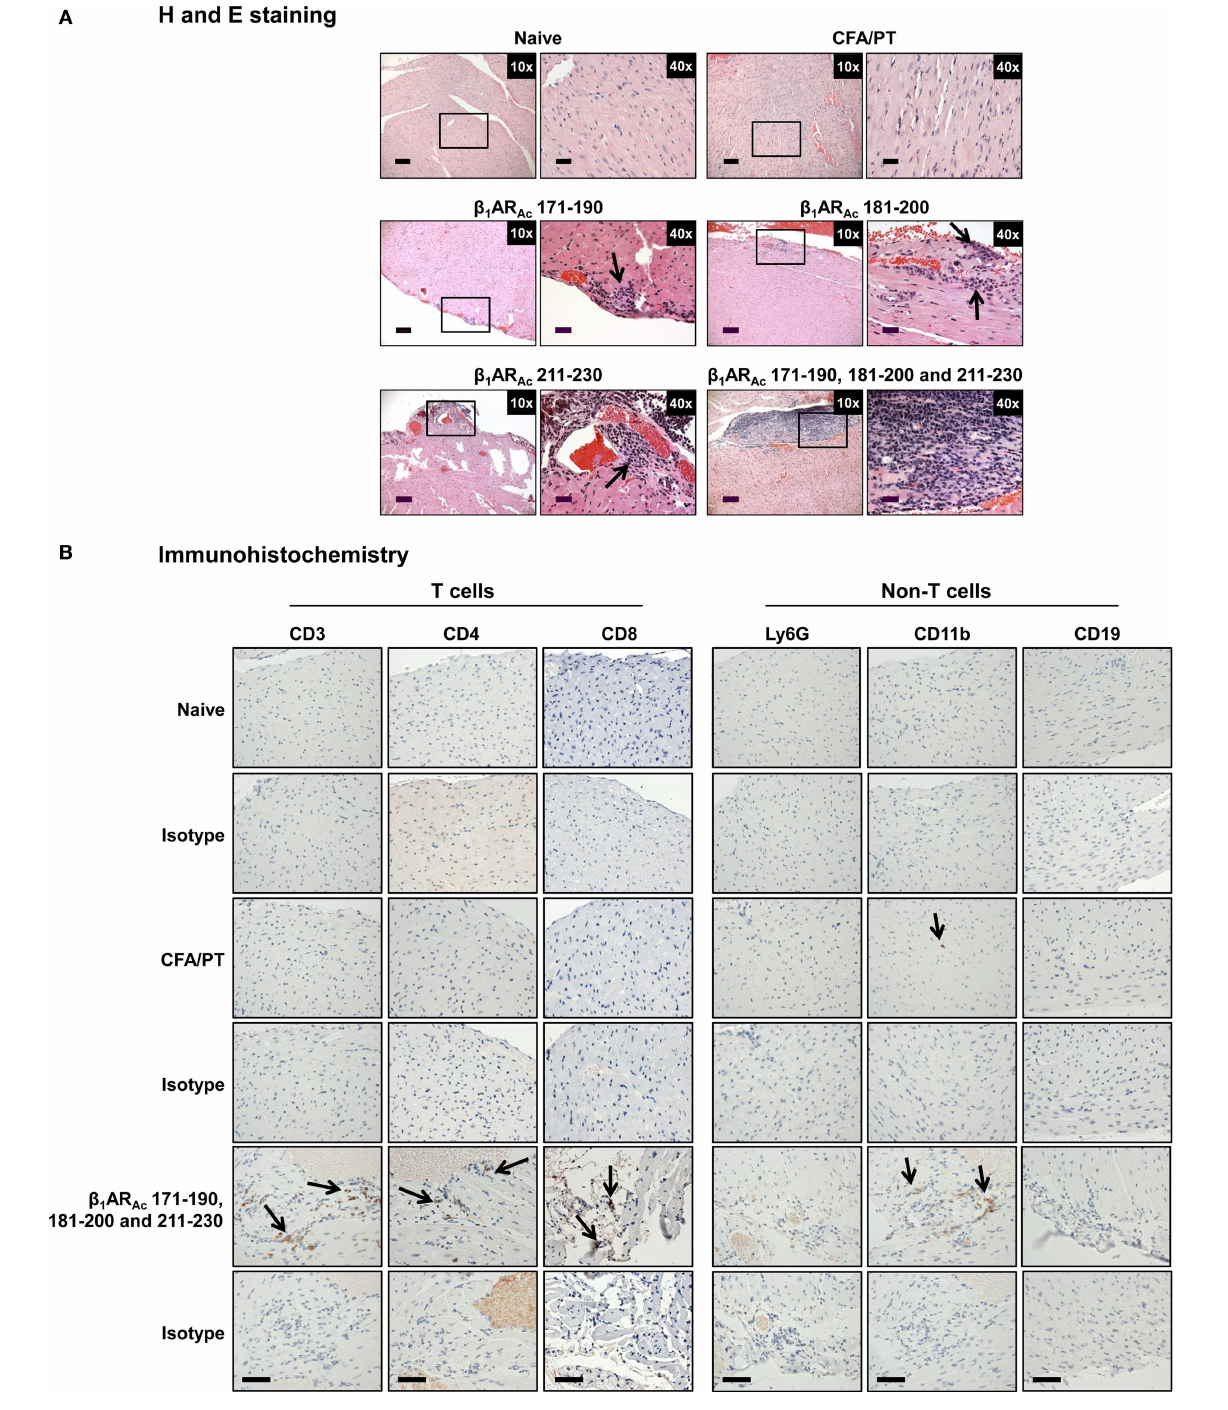
FigUre 2 | Histological evaluation of hearts from animals immunized with β 1 AR Ac peptides. (a) Hematoxylin and eosin (H&E) staining. Groups of mice were immunized with or without indicated peptides in complete Freund’s adjuvant (CFA) twice with an interval of 7 days. At termination on day 21, hearts were collected to determine inflammatory changes by H&E staining analysis. Mild myocarditis as indicated by infiltrates containing mononuclear cells (MNCs) were noted in all groups. Boxed areas are shown at higher magnifications to the right in each panel. Arrows, inflammatory foci. Scale bar: 120 µm (overview images, 10 × ), 30 µm (magnifications, 40 × ). (B) Immunohistochemistry. Heart sections obtained from animals immunized with a mixture of β 1 AR Ac 171–190, 181–200, and 211–230 were evaluated for the presence of T cells (CD3, CD4, and CD8) and non-T cells (Ly6G + neutrophils, CD11b + macrophages and CD19 + B cells) using antibodies for each marker or their isotype controls. After washing and addition of horseradish peroxidase (HRP)-conjugated secondary antibodies, cells positive for each marker were identified as shown with arrows. Representative sections from groups involving five to eight mice are shown. Naive and CFA/PT, controls; and scale bar, 60